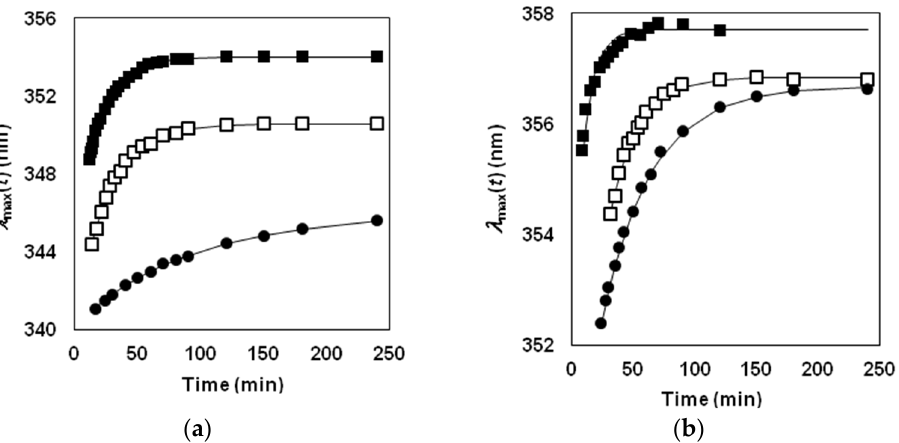
Figure 2. Dependences of the wavelength of the maximum fluorescence on proteolysis time: ( a ) proteolysis of β -LG (0.25 g/L) by trypsin at a concentration of 15 ( ■ ) , 4.5 ( □ ) and 0.9 mg/L ( ● ); ( b ) teolysis of β -LG (0.25 g/L) by trypsin at a concentration of 15 ( (cid:4) ), 4.5 ( (cid:3) ) and 0.9 mg/L ( • ); ( b ) prote- proteolysis of β -CN (0.25 g/L) by trypsin at a concentration of 2.5 ( ■ ) , 0.5 ( □ ) and 0.25 mg/L ( ● ). olysis of β -CN (0.25 g/L) by trypsin at a concentration of 2.5 ( (cid:4) ), 0.5 ( (cid:3) ) and 0.25 mg/L ( • ). Solid Solid lines correspond to the fitting of experimental points using Equation (11). lines correspond to the fitting of experimental points using Equation